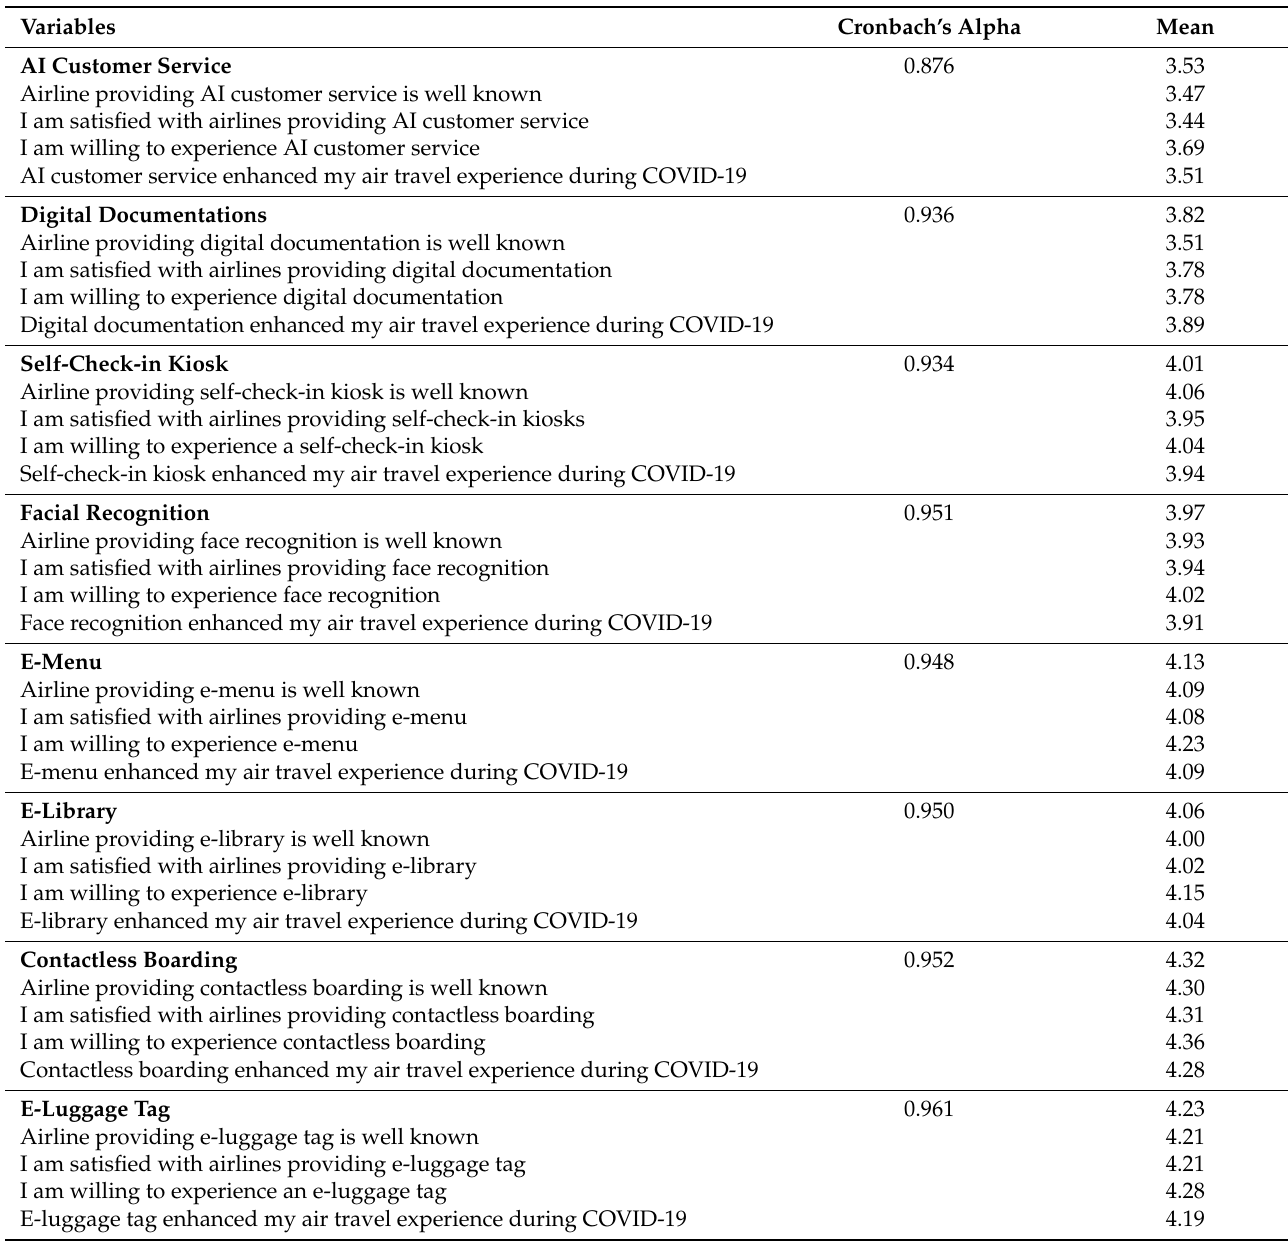
Table 2. Reliability analysis and